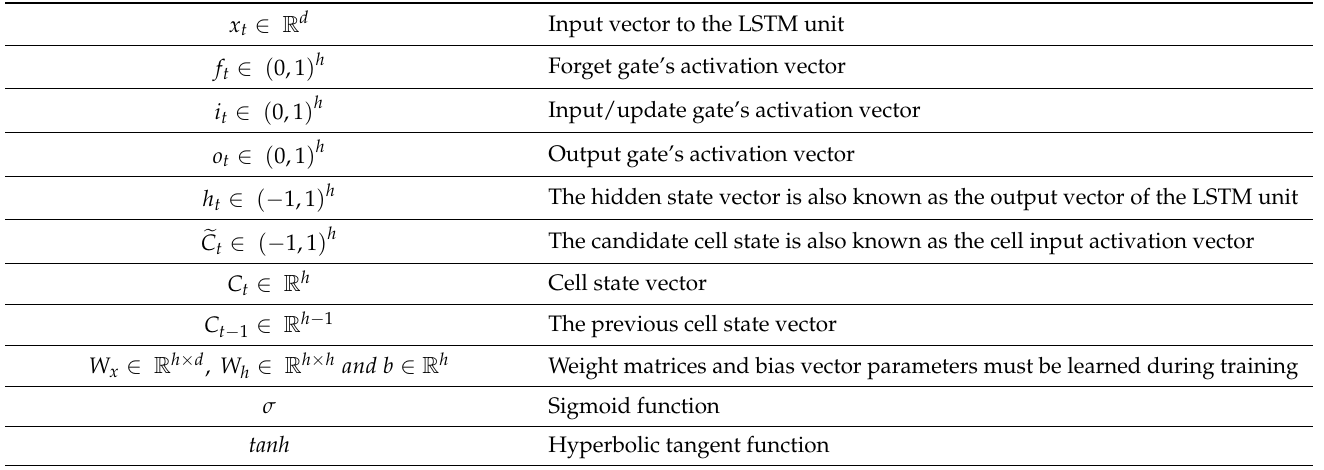
Table 1. List of LSTM